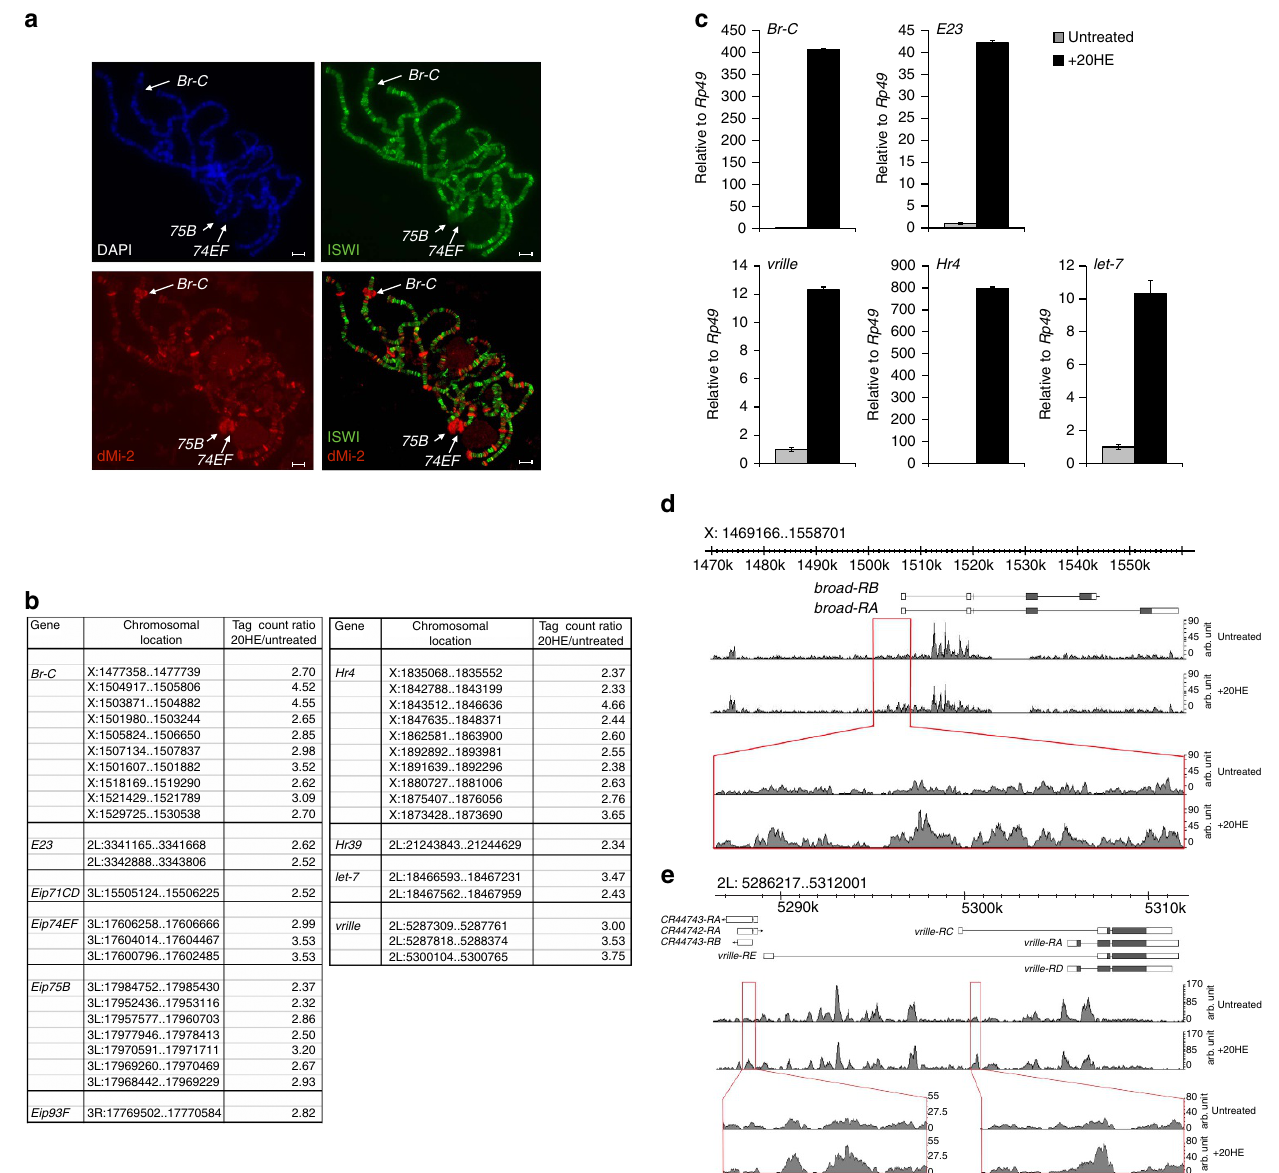
Figure 1 | dMi-2 binds ecdysone-activated genes. ( a ) Polytene chromosomes were stained with DAPI (upper left panel), ISWI antibody (upper right panel) or dMi-2 antibody (lower left panel) and analysed by immunofluorescence. Lower right panel shows overlay of ISWI and dMi-2 signals. Arrows indicate three early ecdysone-induced puffs: Br-C , 74EF , and 75B . Scale bar is 10 m m. ( b ) Regions with ecdysone-induced increased dMi-2 binding (EIMRs) within known ecdysone-activated genes. Cells were treated for 6h with 1 m M 20HE. ( c ) RNA expression of EIMR-containing genes in S2 cells was determined by RT–qPCR. Ratios of RNA levels of the gene of interest to rp49 RNA levels in untreated and 20HE-treated cells were calculated. The ratio determined in untreated cells was set to 1 and the ratio in ecdysone-treated cells was expressed relative to this. Error bars denote s.d. of technical triplicates. ( d ) dMi-2 ChIP-seq profile across the Br-C locus in untreated and ecdysone-treated ( þ 20HE) S2 cells. Top: schematic representation of Br-C locus. Only two Br-C transcripts are shown for clarity; see Supplementary Fig. 1a for complete set. Bottom: magnification of most prominent EIMR-containing region within Br-C . ( e ) dMi-2 ChIP-seq profile across the vrille locus in untreated and ecdysone-treated ( þ 20HE) S2 cells. Top: schematic representation of vrille locus. Bottom: magnification of two EIMR-containing regions.